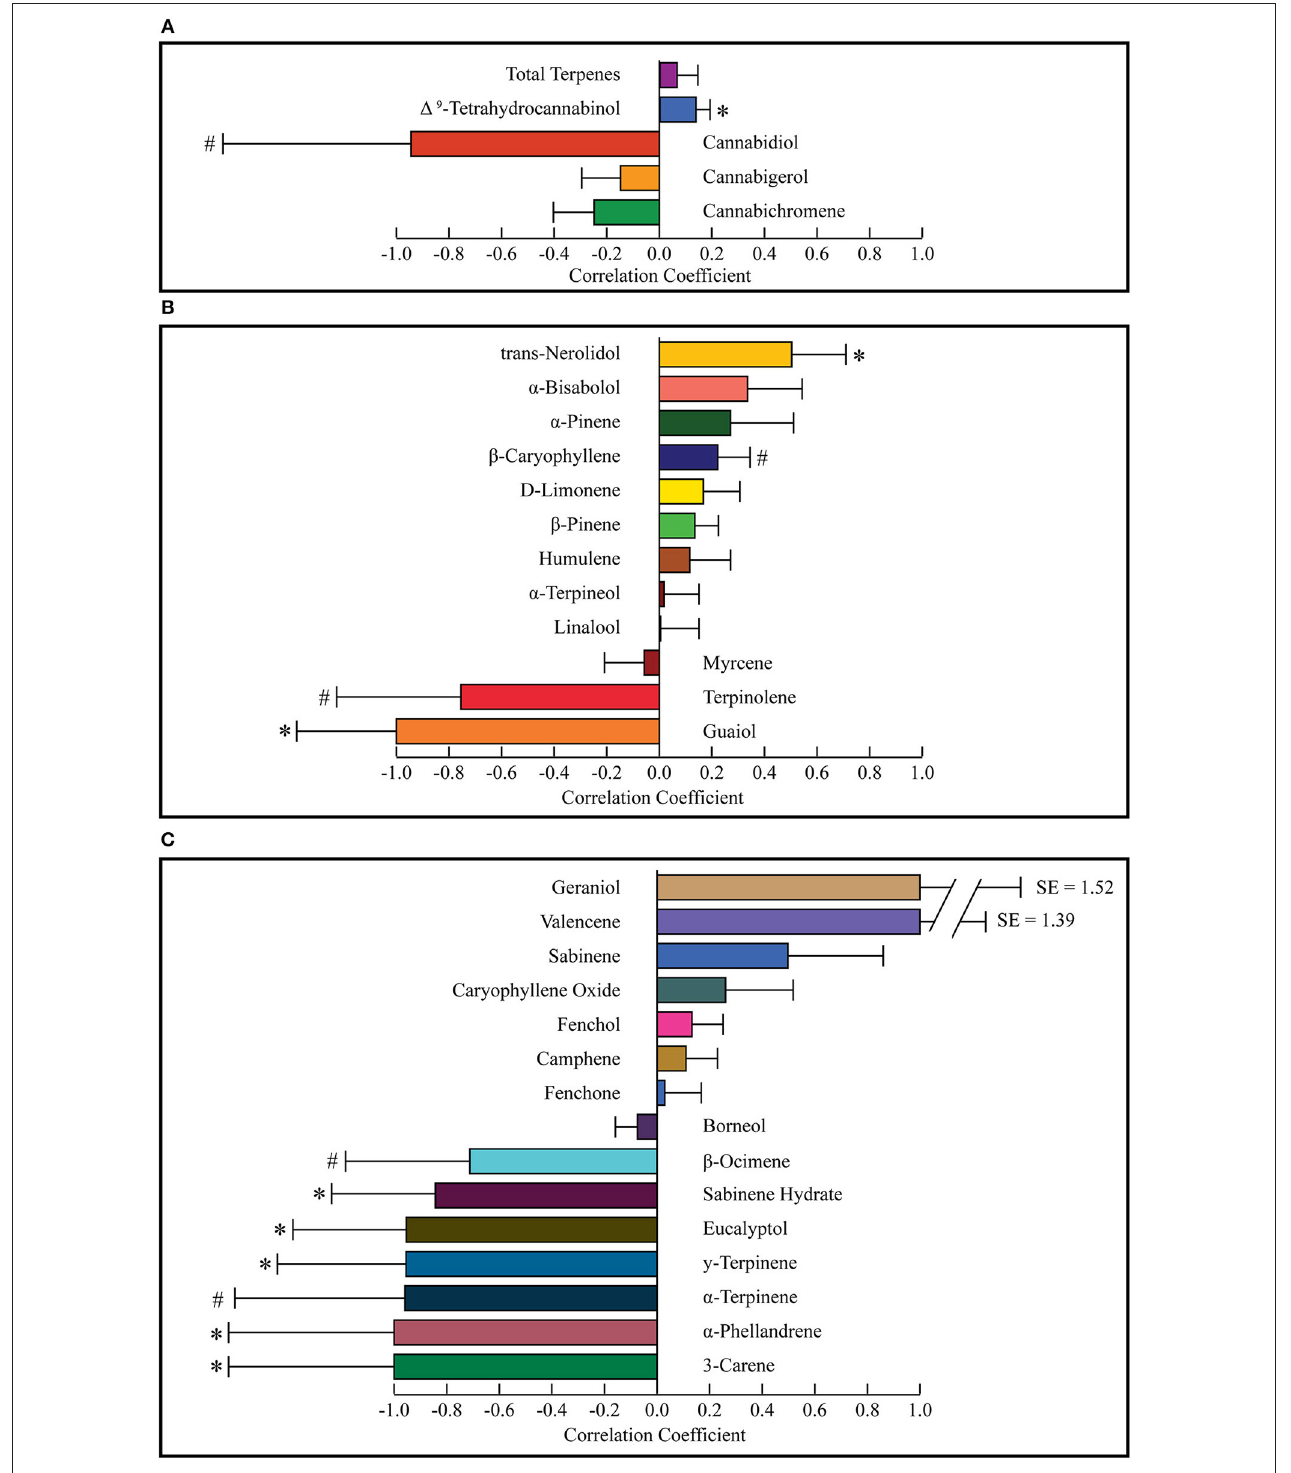
FIGURE 4 | Correlation coefficients for cannabinoids and total terpenes (A) major terpenes (B) , and minor terpenes (C) . Correlation coefficients were calculated for each constituent using a difference of means test. The weighted average of the least effective was subtracted from the most effective and divided by their sum to calculate the correlation coefficient. Weighted standard distributions were used to calculate p -values with a two-sided t -test. Values market with * indicate p < 0.05 and those marked with # indicate 0.05 < p < 0.10. SE, Standard Error.